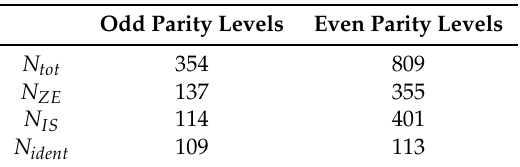
Table 1. Summary of experimental data available for the parametric interpretation of U II levels. N tot : total number of levels; N ZE : number of levels with Landé factor measured by Zeeman effect, N IS : number of levels with measured isotope shift; N ident : number of levels with empirical identification. The number of classified lines per level was not given in [6]. Odd Parity Levels Even Parity Levels N tot 354 809 N ZE 137 355 N IS 114 401 N ident 109